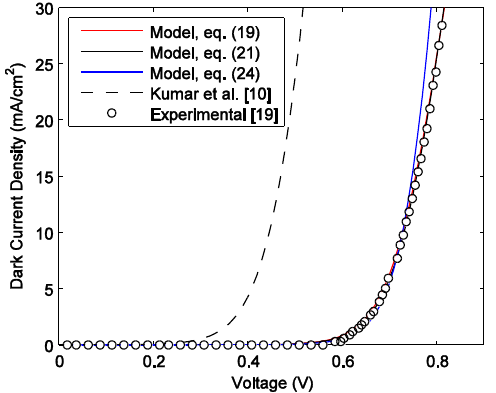
Figure 3. Dark current-voltage characteristics of a PTB7:PC 71 BM solar cell.